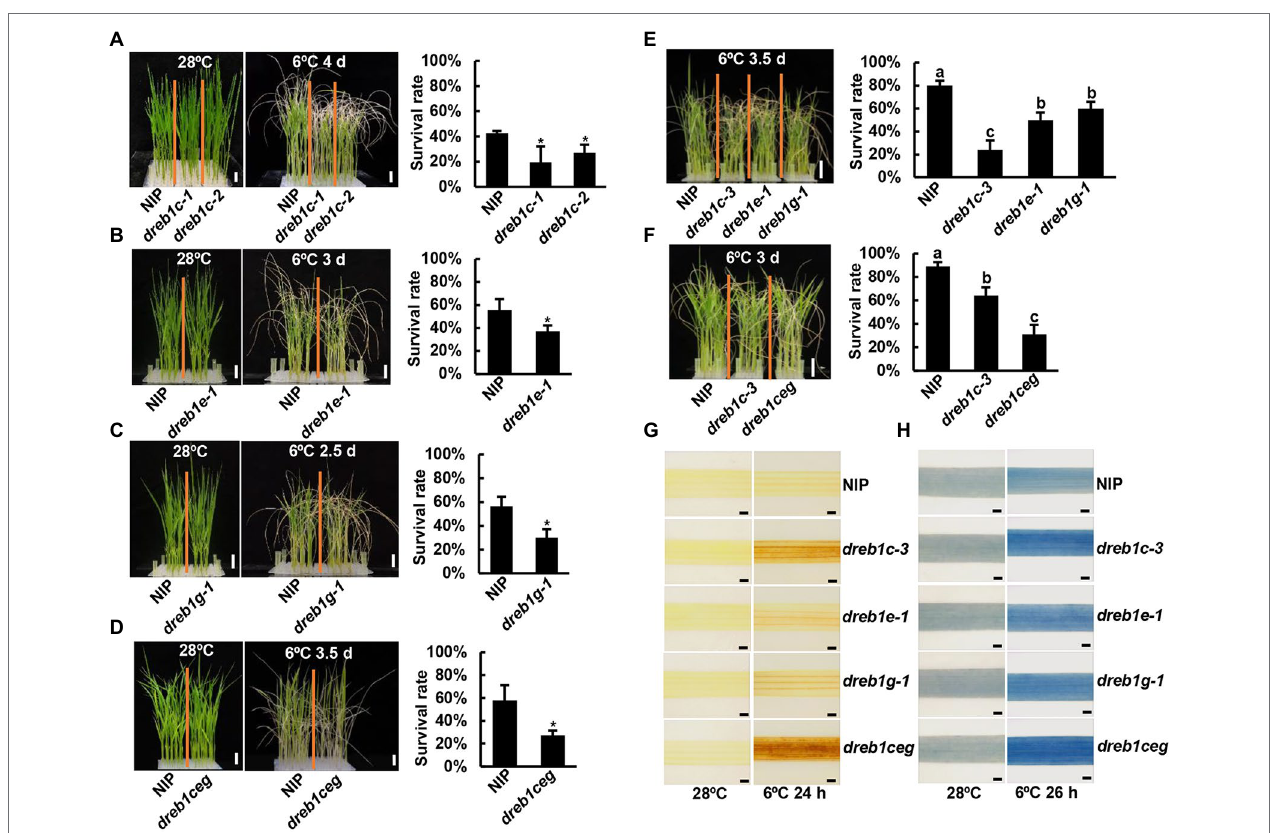
FIGURE 2 | The dreb1 mutants are more susceptible to chilling at seedling stage. (A–F) Growth phenotypes and survival rates of dreb1c and WT (A) , dreb1e and WT (B) , dreb1g and WT (C) , dreb1ceg and WT (D) , dreb1c , dreb1e , dreb1g, and WT (E) as well as dreb1c , dreb1ceg , and WT (F) after chilling treatment and recovery. Seedlings were hydroponically grown at 28 ° C for 3 weeks, incubated at 6 ° C (for 2.5–4 days as indicated) and then transferred to normal conditions for 7 days for recovery. Left panels show plant morphology and bars = 2 cm. Right panels show mean values of survival rates from three biological replicates ±SD (standard deviation). Each biological replicate has more than 24 seedlings. Asterisks indicate significant differences compared to NIP (* p < 0.05, Student’s t -test). Lowercase letters above the bars indicate significant differences among samples at p < 0.05, by SSR-Test. (G,H) DAB (G) and trypan blue (H) staining of the second leaves of dreb1c-3 , dreb1e-1 , dreb1g-1 , dreb1ceg , and NIP plants before and after chilling treatment at 6 ° C for 24 h (DAB) or 26 h (trypan blue). Bars = 1